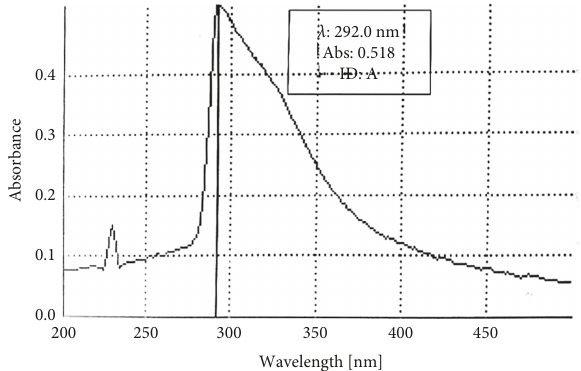
Figure 2: UV spectrum of aqueous extract of Antiaris africana